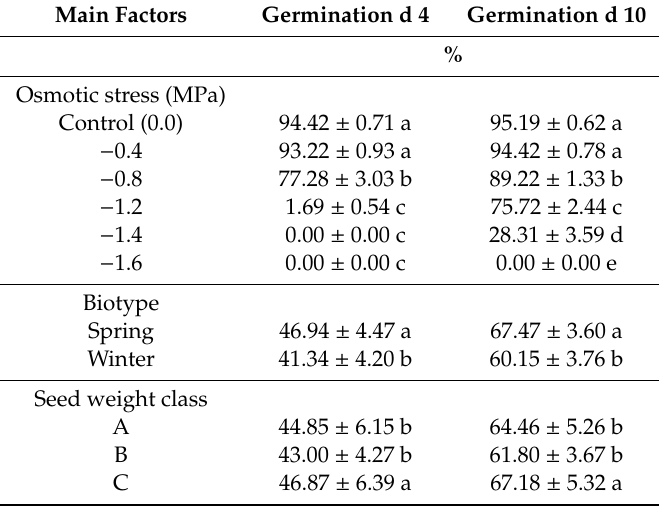
Table 3. Camelina germination percentage (%), surveyed at 4 and 10 days after stress imposition, as affected by the main factors: osmotic stress level (0 vs. − 0.4 vs. − 0.8 vs. − 1.2 vs. − 1.4 vs. − 1.6 MPa), biotype (winter vs. spring), and seed weight classes ((A) TSW > 1.27 g vs. (B) 0.98 g < TSW < 1.27 g vs. (C) TSW < 0.98 g). Mean values ± SE. Different letters: statistically different means within the same factor (i.e., osmotic stress, biotype, seed weight class) and germination day (i.e., d 4, d 10) for p ≤ 0.05 (LSD’s